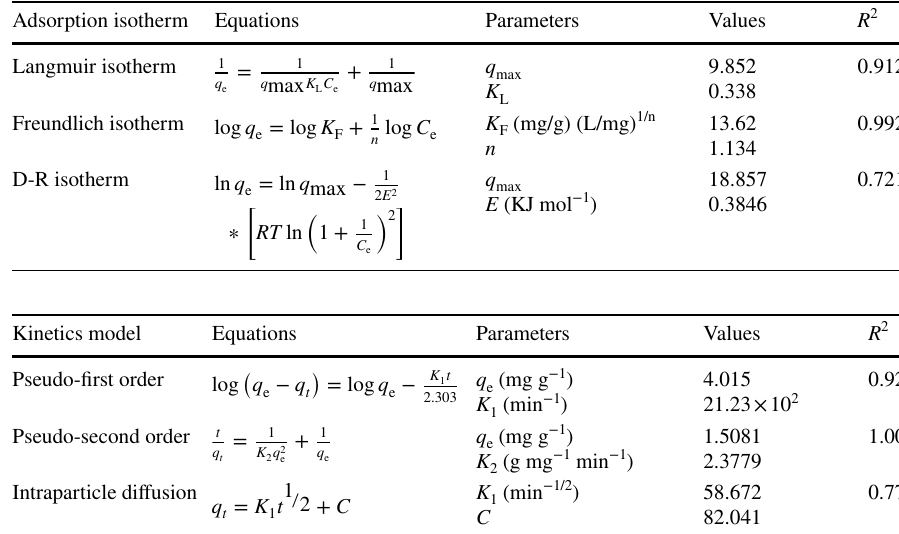
Table 2 Summary of parameters for various kinetic models by human hair